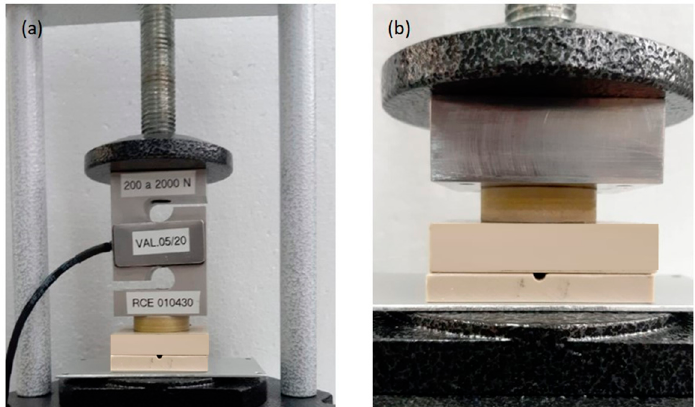
Figure 6. Positioning of the sensor in the hydraulic press machine to perform the static tests. ( a ) Sensor in series with a commercial strain gauge and ( b ) without the presence of the commercial strain gauge. See the online video V1 about this measurement.